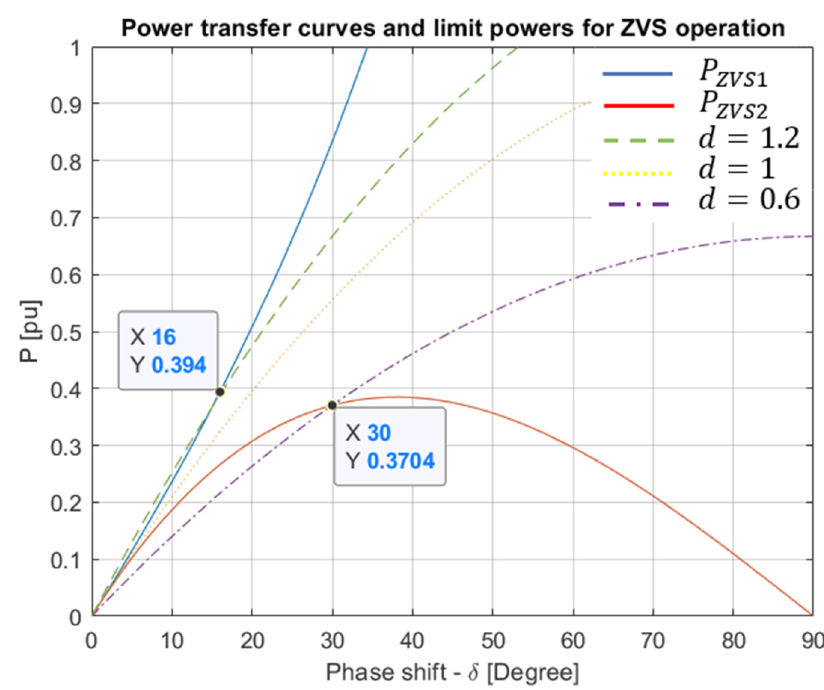
Figure 3. Power transfer curves and limit powers for ZVS operation.